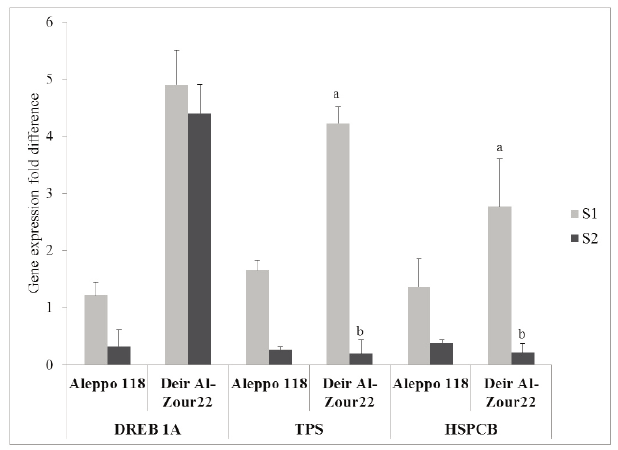
Fig. 8 - Fold expression of DREB1A, TPS and HSPCB genes in lea- ves of treated ‘Aleppo 118’ and ‘Deir Al-Zour 22’ plants. Leaf samples were collected in two stages, S1 (during flo- ral bud to flower transition stage) and S2 (bolls opening and maturation). Data were subjected to Duncan’s test with a confidence level of 95% using STATISTICA pro- gram. Significant fold expression change of TPS and HSPCB genes was observed between S1 and S2 treated ‘Deir Al-Zour 22’. Data represent means and standard deviation of three